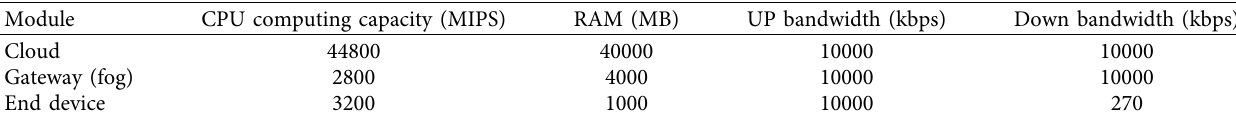
Table 3: Te simulation